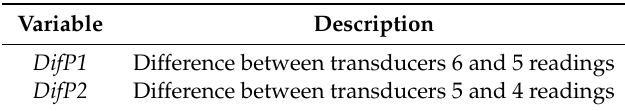
Table 1. Description of pressure differential variables